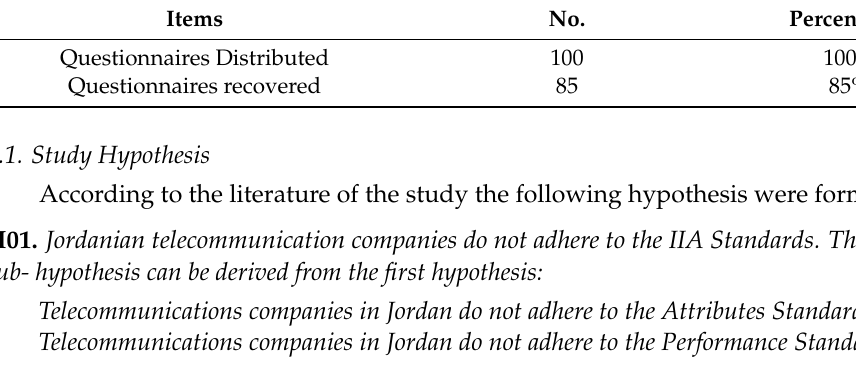
Table 1. Results of research community. Items No. Percentages Questionnaires Distributed Questionnaires